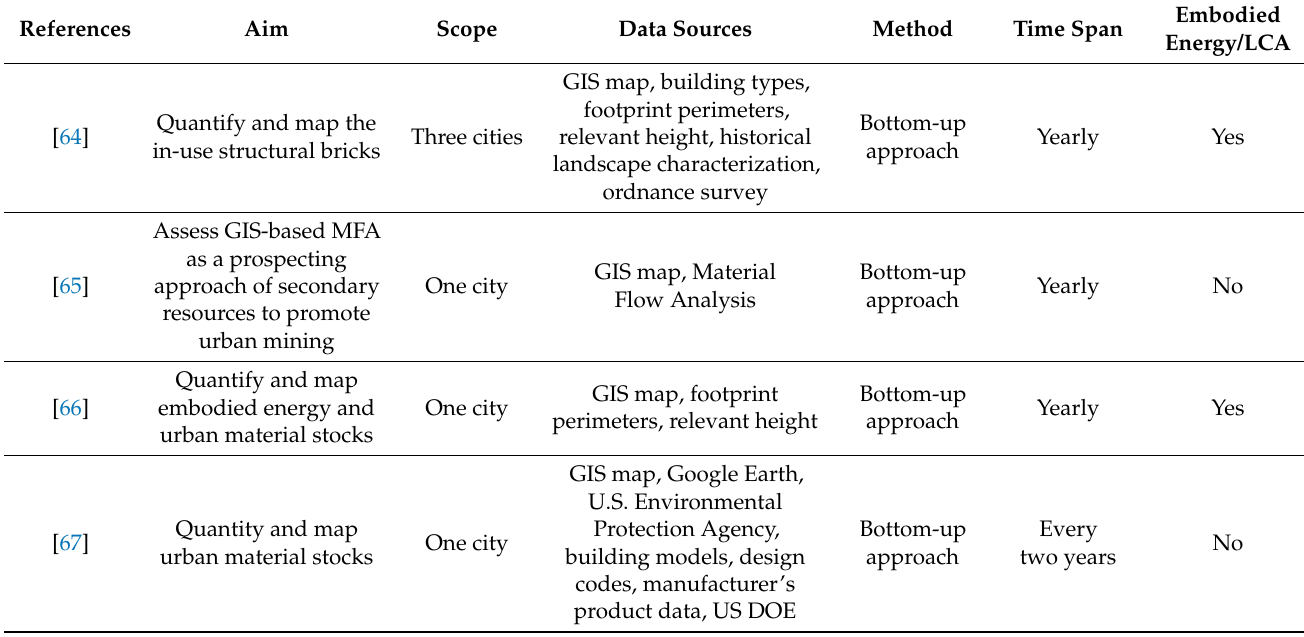
Table 1. Previous research papers on mapping and quantifying the urban building stocks and specific building materials (i.e., steel, concrete, and brick) using GIS